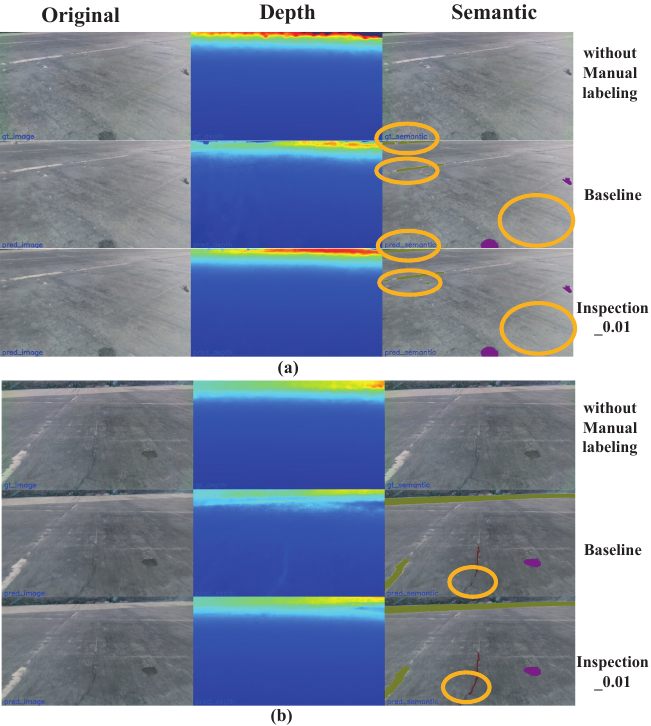
Figure 10. Multi-type rendering results comparison without manual labeling of validation data. The orange ellipse in ( a ) marks the restoration comparison of the long-distance patched area and short-distance spot semantics, and the semantic restoration comparison of crack defects is marked in ( b